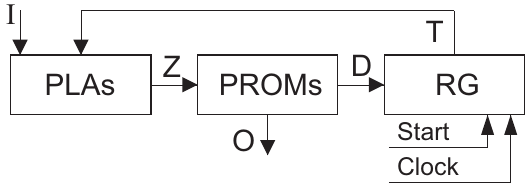
Figure 16. The structural diagram of PH